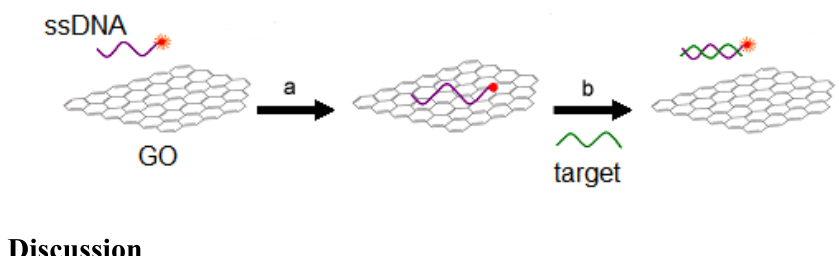
Figure 1. Schematic representation of the target-induced fluorescence change of the single-stranded DNA (ssDNA)–graphene oxide (GO)